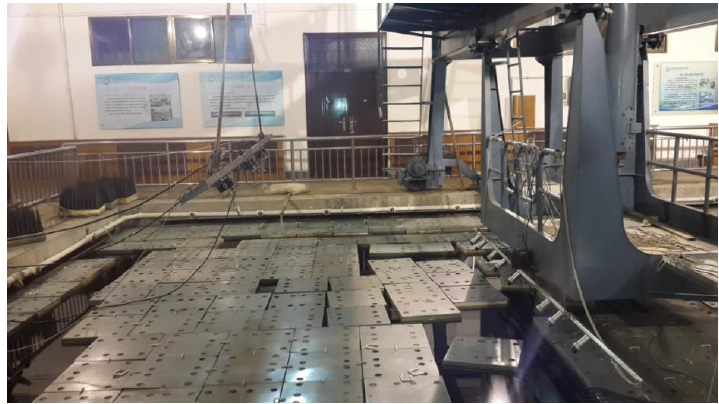
Figure 7. The anechoic tank laboratory.